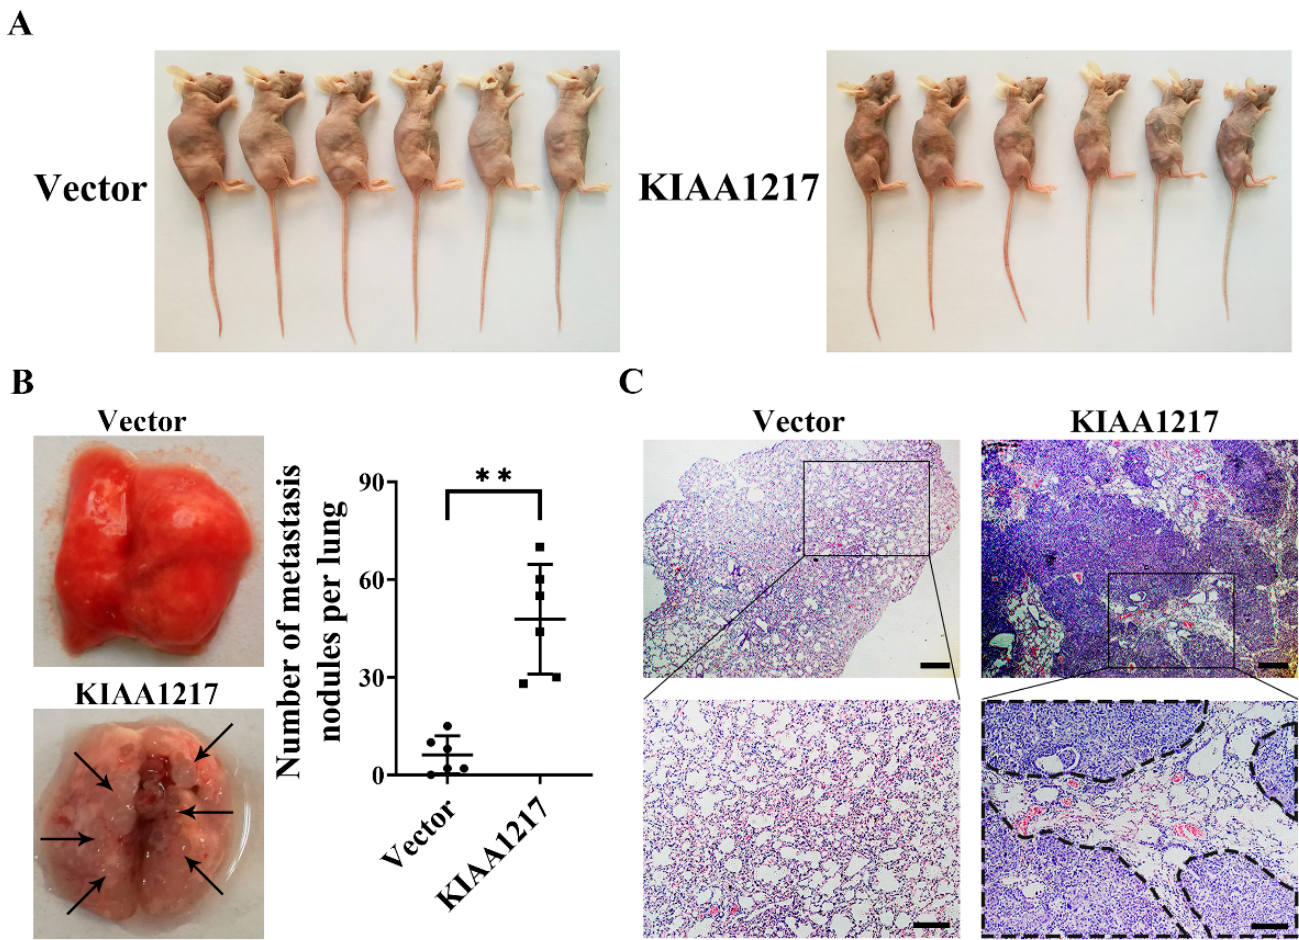
Figure 3. KIAA1217 promoted lung metastasis in vivo. HepG2 cells stably overexpressing KIAA1217 or the vector control were injected intravenously into the tail vein of nude mice. ( A ) Representative images of the physical appearance of nude mice in each group. ( B ) Representative pictures of lungs derived from nude mice in each group and the number of metastatic nodules on the surface of the lungs from each group. ** p < 0.01. Error bars: SEM. ( C ) Representative images of H&E staining of lung tissues from the different groups. Dotted lines indicated metastatic lesions. Magnification × 40 (upper panel) and × 100 (lower panel); scale bars: 200 µ m (upper panel) and 100 µ m (lower